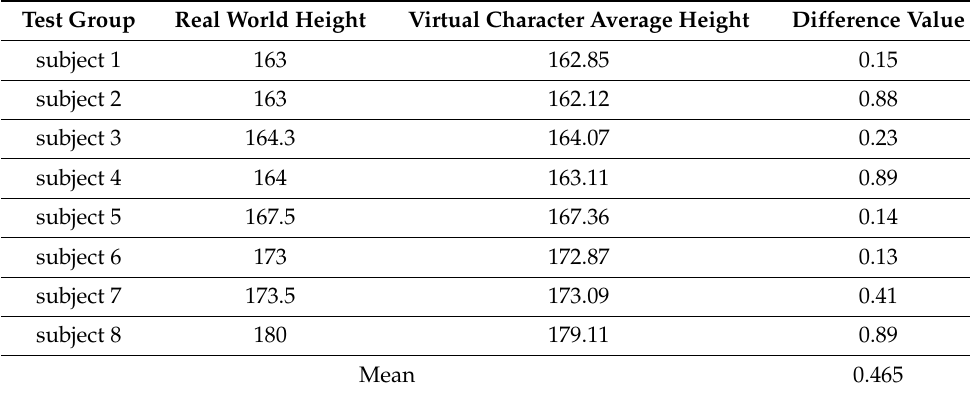
Table 3. Character size synchronization error value calculation [Unit: